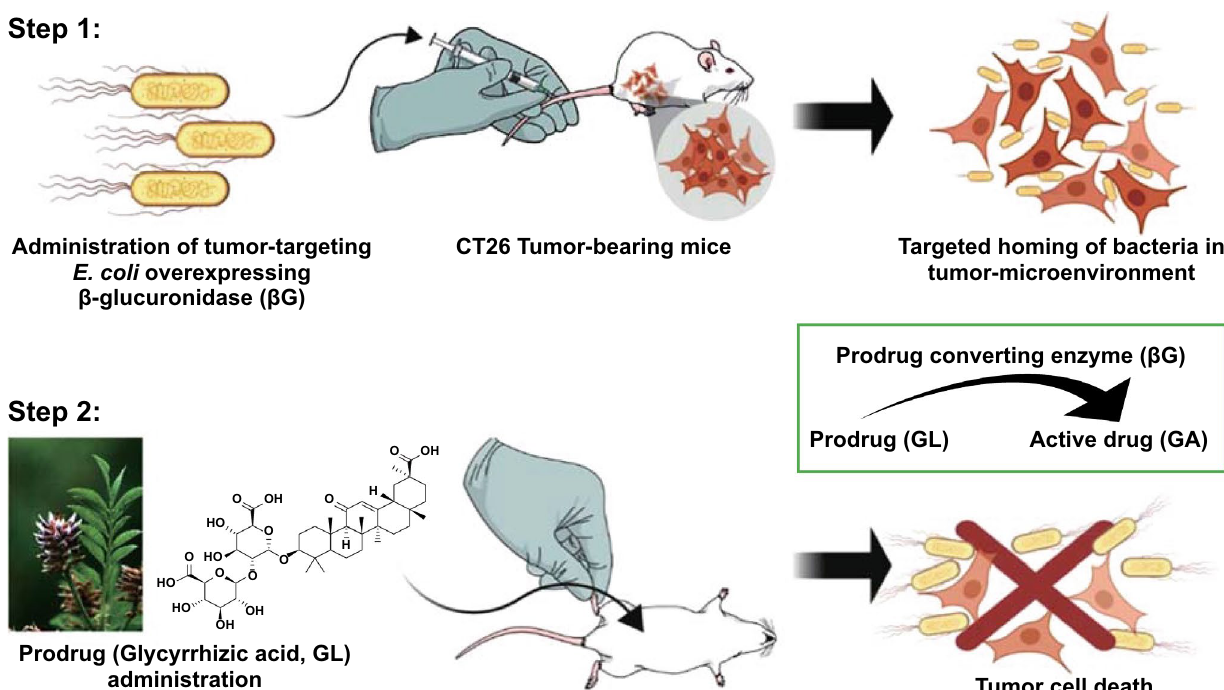
Fig. 9 Schematic of engineered E. coli overexpressing β-glucuronidase (βG) combined with prodrug (glycyrrhizic acid, GL) for tumor treat- ment. Step 1, engineered E. coli overexpressing β-glucuronidase (βG) is injected intravenously into a tumor-bearing mice model and then colo- nizes in the tumor site. Step 2, GL is activated by βG into a cytotoxic antitumor drug (glycyrrhetinic acid, GA) at the tumor site to eliminate the tumor. Reprinted with permission from Ref.